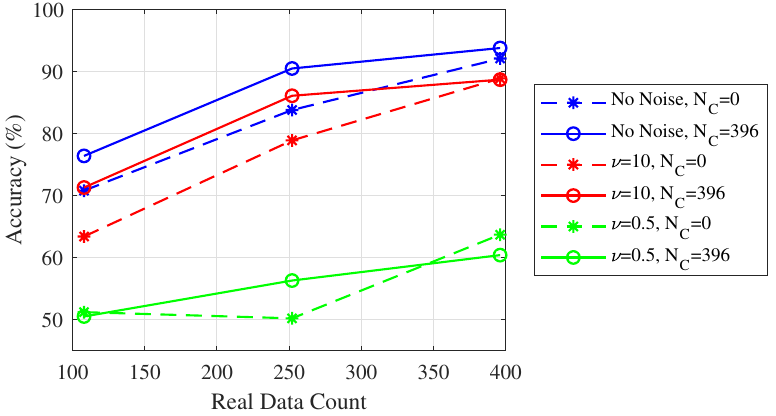
Figure 8. Resulting accuracy of the Vgg architecture when presented with samples corrupted by multiplicative noise. N C represents the count of synthetic data used in